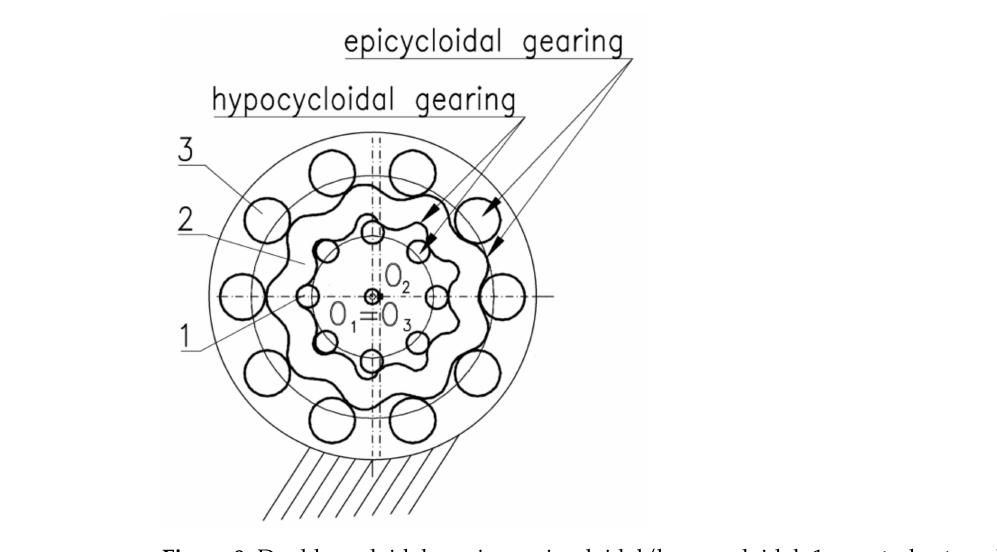
Figure 8. Double cycloidal gearing, epicycloidal/hypocycloidal: 1—central external gear; 2—ring; 3—internal